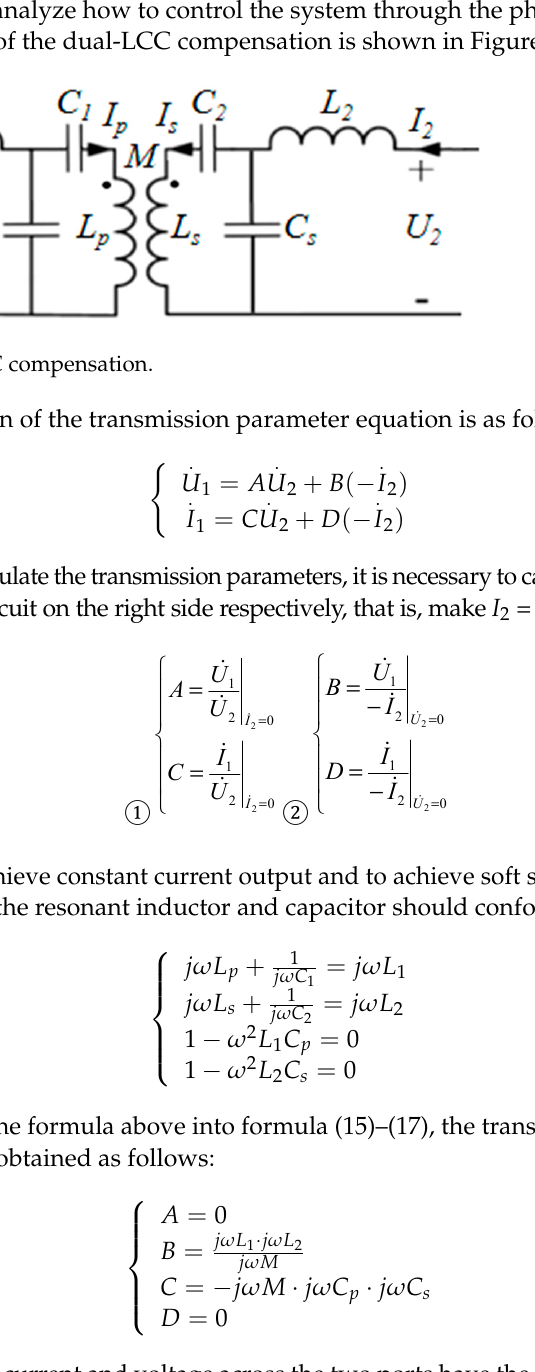
Figure 16. Transmission efficiency characteristic curve of dual-LCC system under different param- eters: ( a ) transmission efficiency—coupling coefficient, ( b ) transmission efficiency—load.